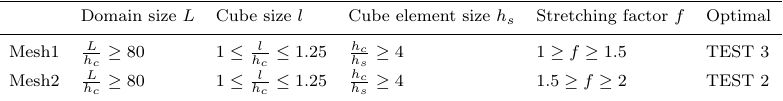
Table 3. Recommended mesh parameters for hexahedron Mesh1 and prismatic Mesh2. Domain size L Cube size